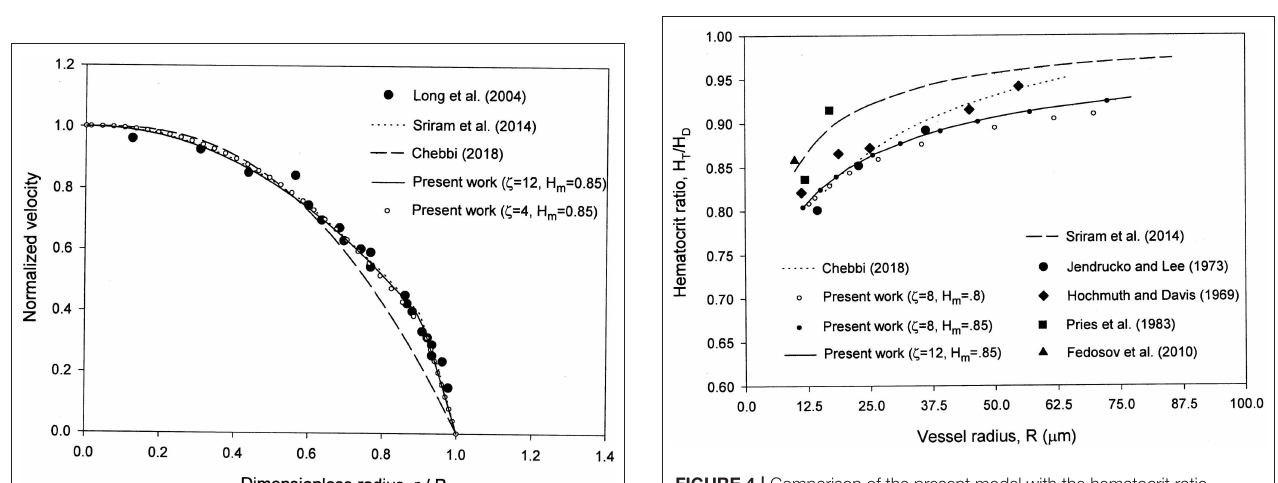
FIGURE 4 | Comparison of the present model with the hematocrit ratio numerical results in Sriram et al. [ 12] and the experimental data in Pries et al. [ 31], Hochmuth et al. [33], Jendrucko and Lee [34], and Fedosov et al. [35] reported in Sriram et al. [12] for H D =